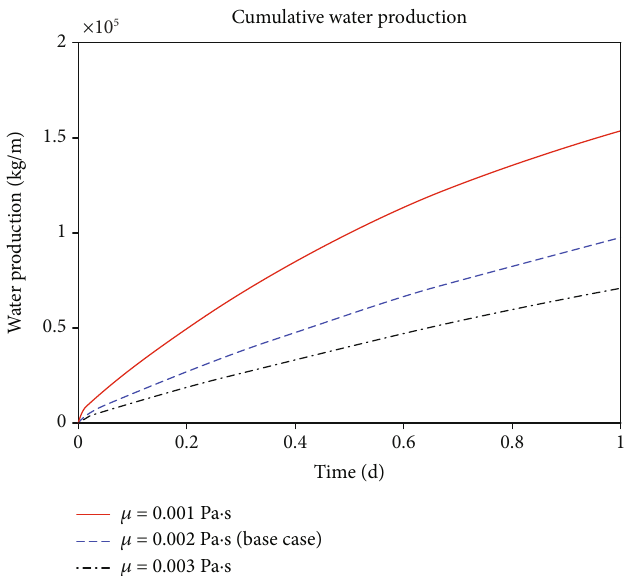
Figure 16: Cumulative water production at the wellbore during one day of shallow water fl ow for viscosity sensitivity.